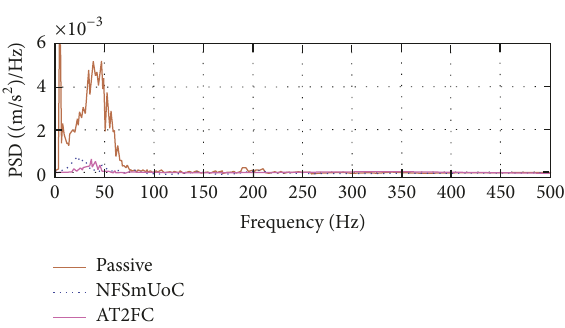
Figure 15: Vertical displacement related to each control method.